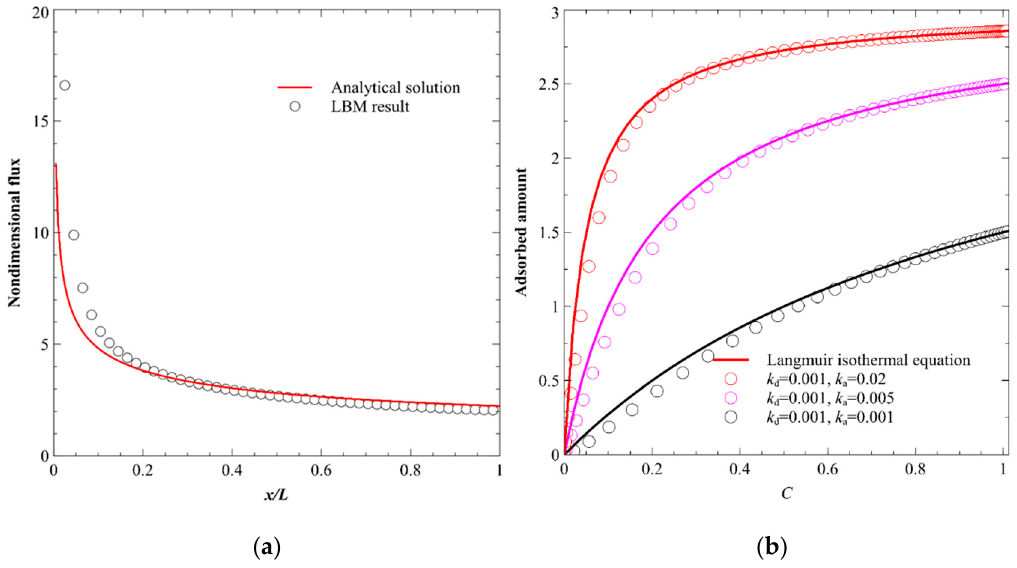
Figure 3. Comparison of the present LB results and the analytical solution. ( a ) Comparison of the LB results and the analytical solution of Henry adsorption. ( b ) Comparison of the LB results and the analytical solution of the Langmuir isotherm adsorption.